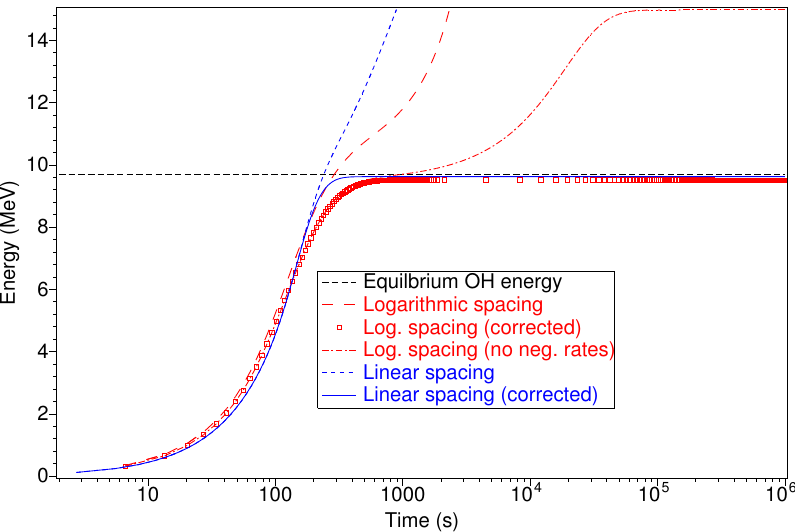
Figure 5. The calculated OH energies as a function of time are shown for logarithmic and linear distributions of 31 subranges, compared with the equilibrium value (– – –). For the linear distribution, uncorrected (- - - -) and corrected (—–) cases are shown, while, for the logarithmic distribution, uncorrected (— —), corrected ( (cid:3) ) and corrected with negative rates reset to zero (– · – · –) are shown. In Figure 7, the OH, electron and total energies are plotted as a function of time, for N = 100 with logarithmic spacing, showing all approaches and then remaining very close to the predicted values. The percentage errors in the total energy are plotted, showing a rise to about 0.09% before falling to 0.03% when equilibrium is attained. (The discontinuity at about 200 s is due to a change in sign in the difference between the simulated and calculated